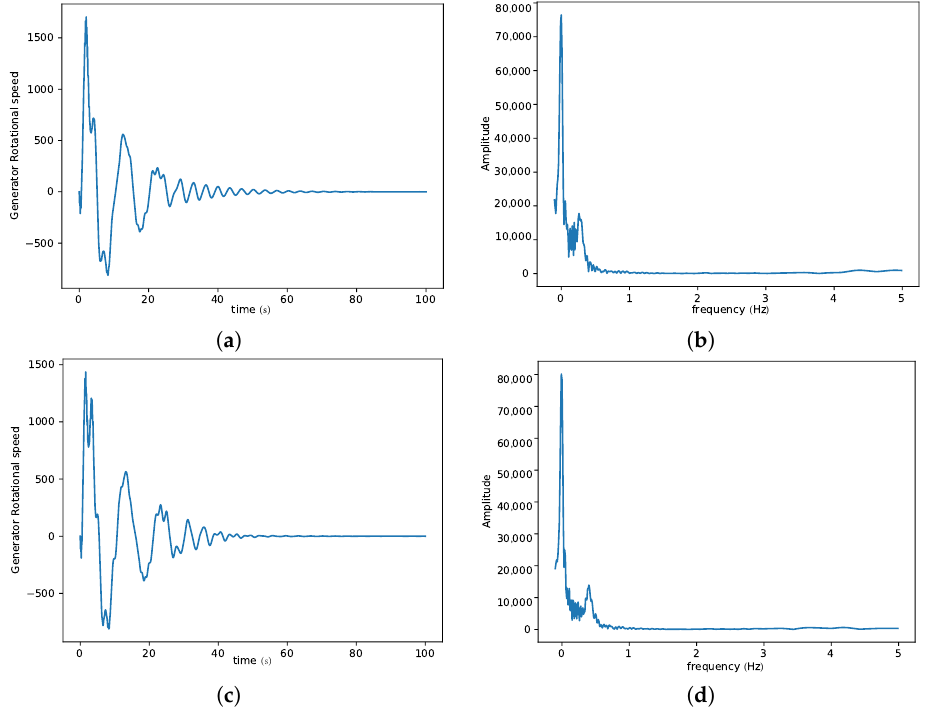
Figure 8. The effect of a bigger helical angle on generator rotational speed ( ˙ θ 4 ). ( a , b ) are the time series and the corresponding FFT frequency spectrum plots for the case β = π /6. In ( c , d ), the helical angle has been set to β = π /12. The other parameters are fixed and listed in Table 2.